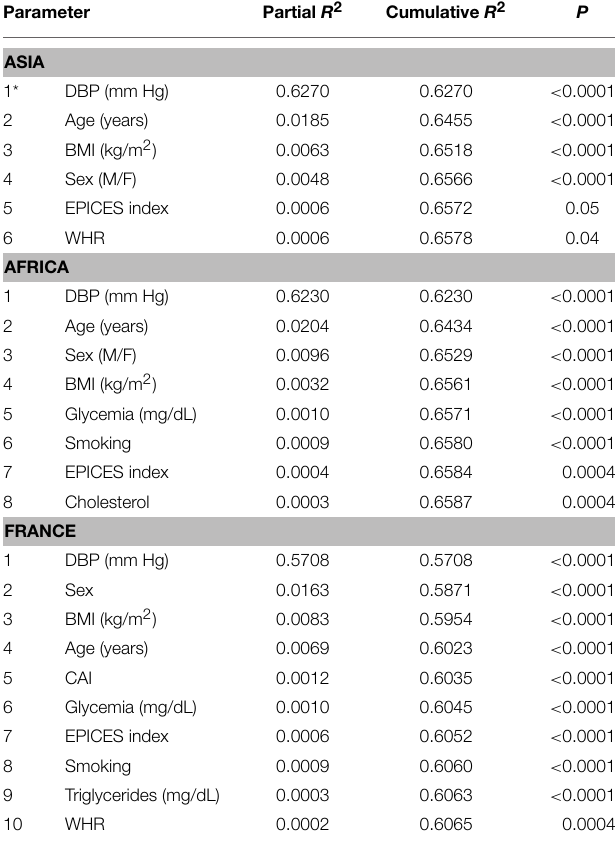
TABLE 5 | Summary of Multiple Regression Models for study of SBP levels according to country of birth in individuals born in Asia, Africa, and